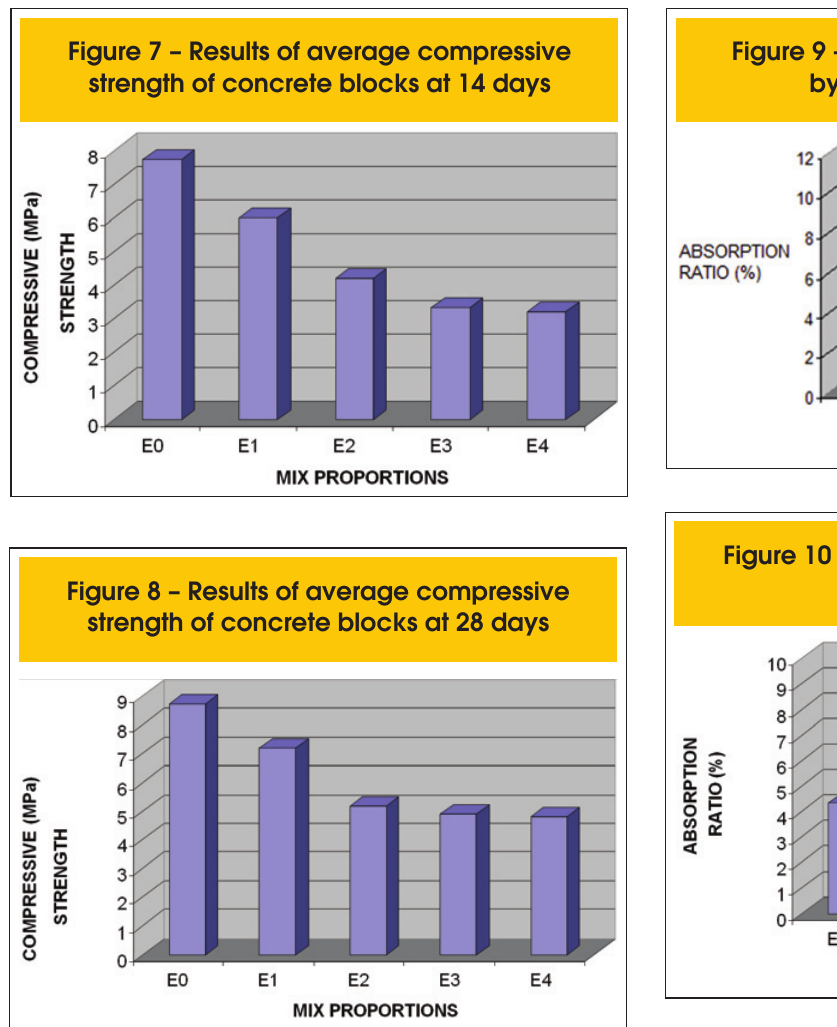
Figure 9 – Test results of water absorption by immersion of specimens